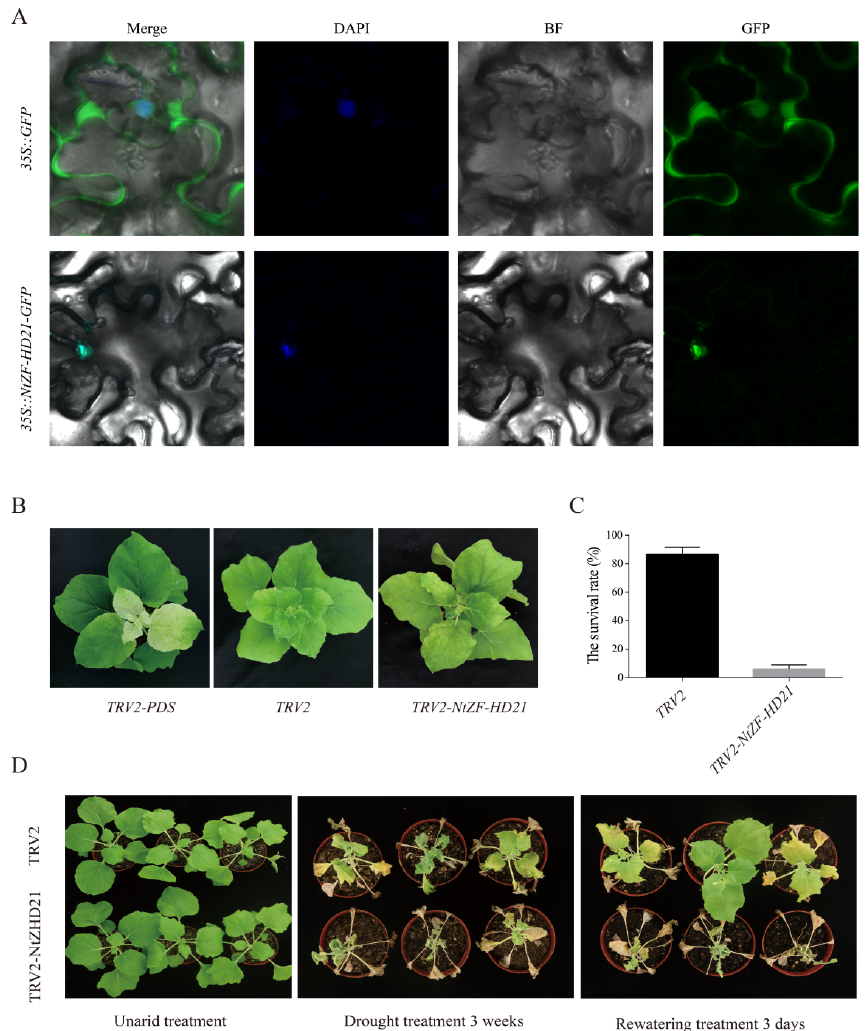
Figure 5. The subcellular localization of NtZF-HD21 and virus-induced gene silencing (VIGS) of the NtZF-HD21 gene in Nicotiana benthamiana . ( A ) The subcellular localization of NtZF-HD21. The NtZF-HD21–GFP fusion construct and GFP gene driven by the CaMV-35S promoter were transiently expressed in Nicotiana benthamiana separately. 4,6-diamidino-2- phenylindole (DAPI) staining indicates the nucleus. ( B ) The phenotype of VIGS of the NtZF-HD21 gene in Nicotiana benthamiana. ( C ) The survival rate of silent plants and negative controlled plants. ( D ) The silence of NtZF-HD21 gene conferred the drought tolerance of tobacco.